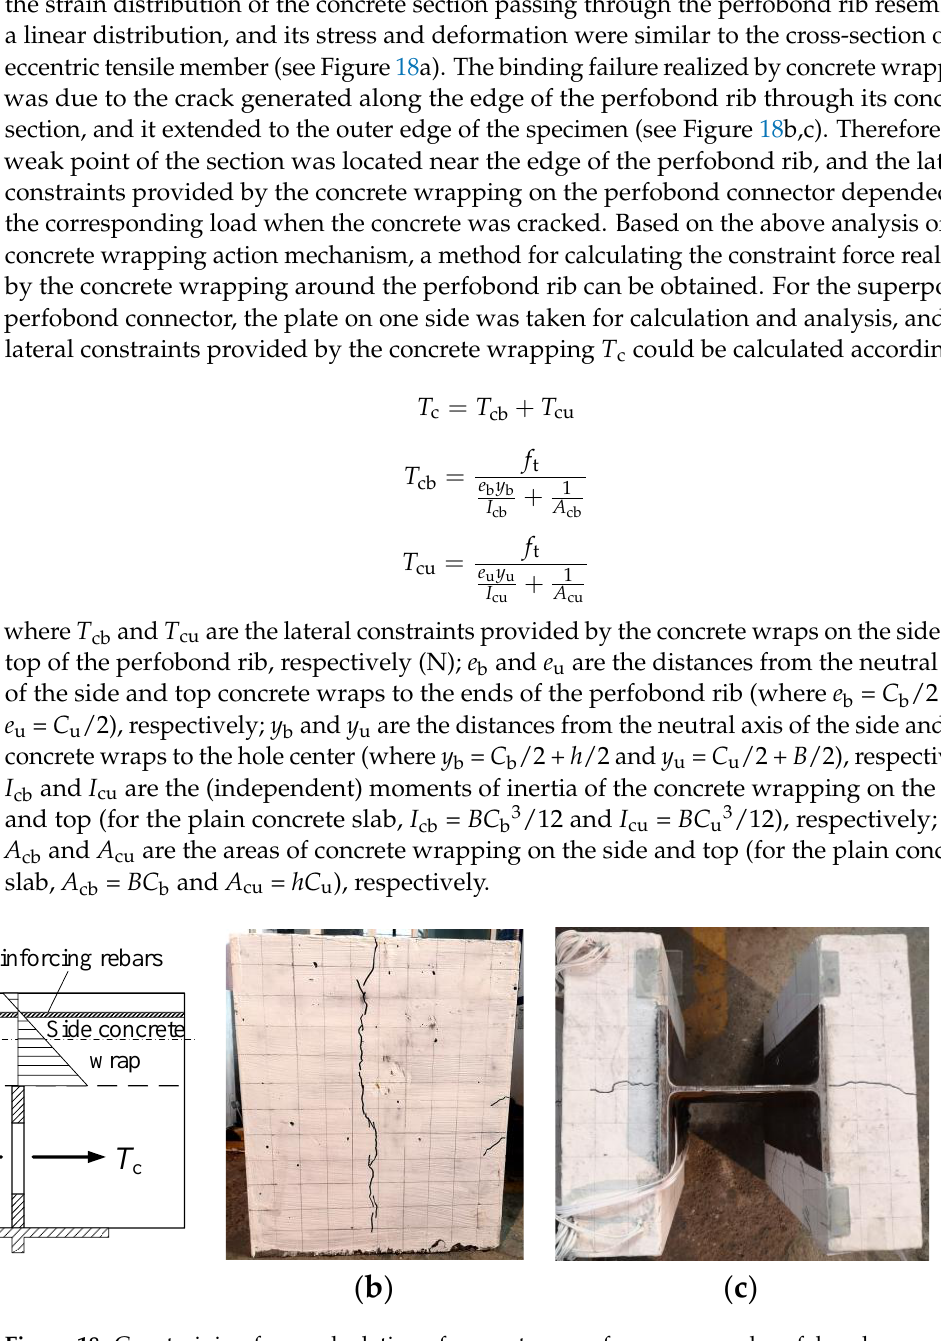
Figure 18. Constraining force calculation of concrete wrap for superposed perfobond connectors: ( a ) Side concrete wrap [35]; ( b ) Cracking of side concrete wrap; ( c ) Cracking of upper concrete wrap.